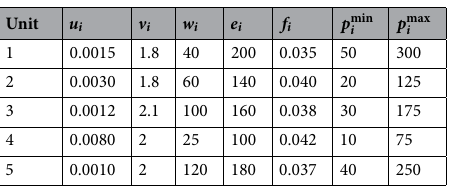
Table 6. Thermal units cost input data for case study-II.